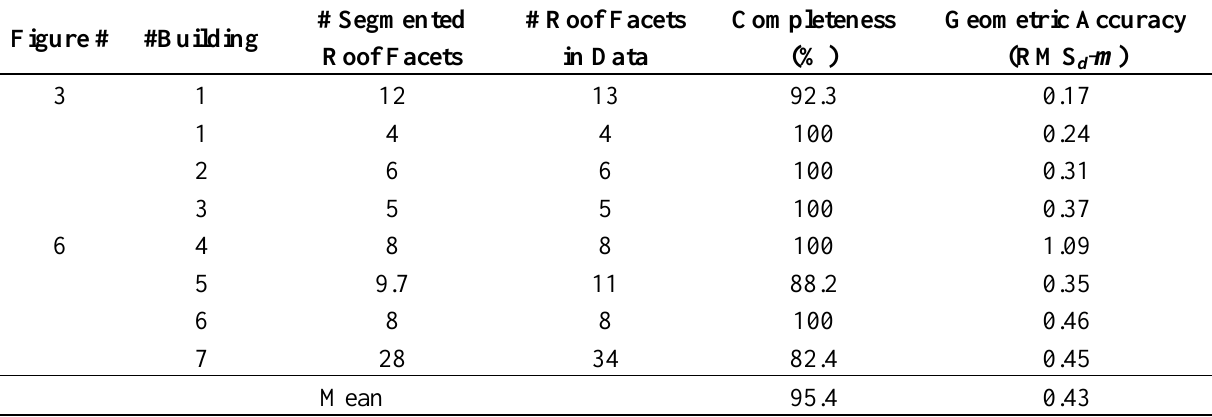
Table 2. Completeness of the